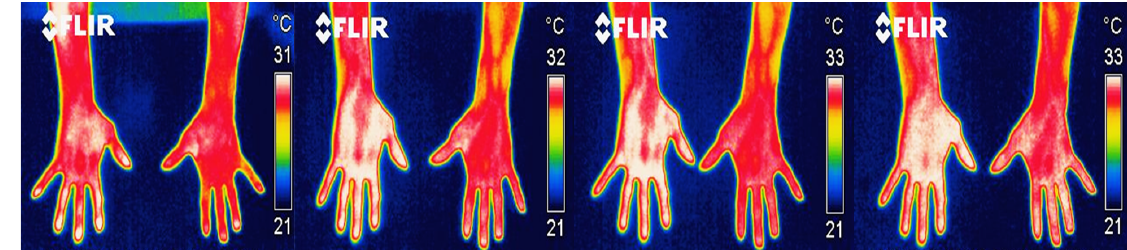
Figure 5. Example of thermogram taken from the front area of the palm at the times 5 ′ , 10 ′ , 15 ′ , and 20 ′ .